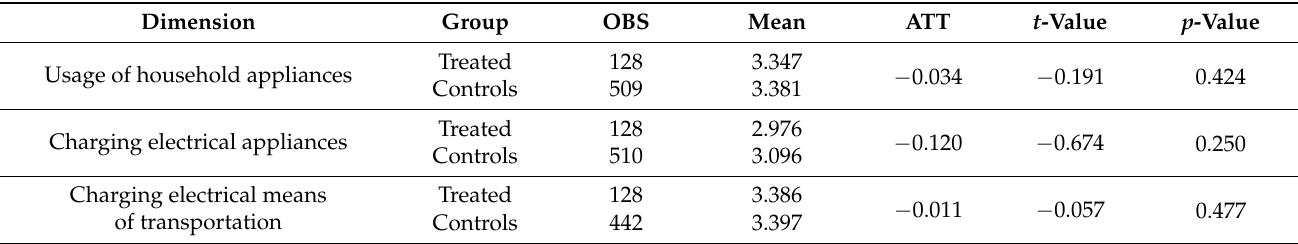
Table 7. Demand flexibility comparisons of Solar-consumers (treated) versus Non-owners (controls) (source: authors’ own calculations).